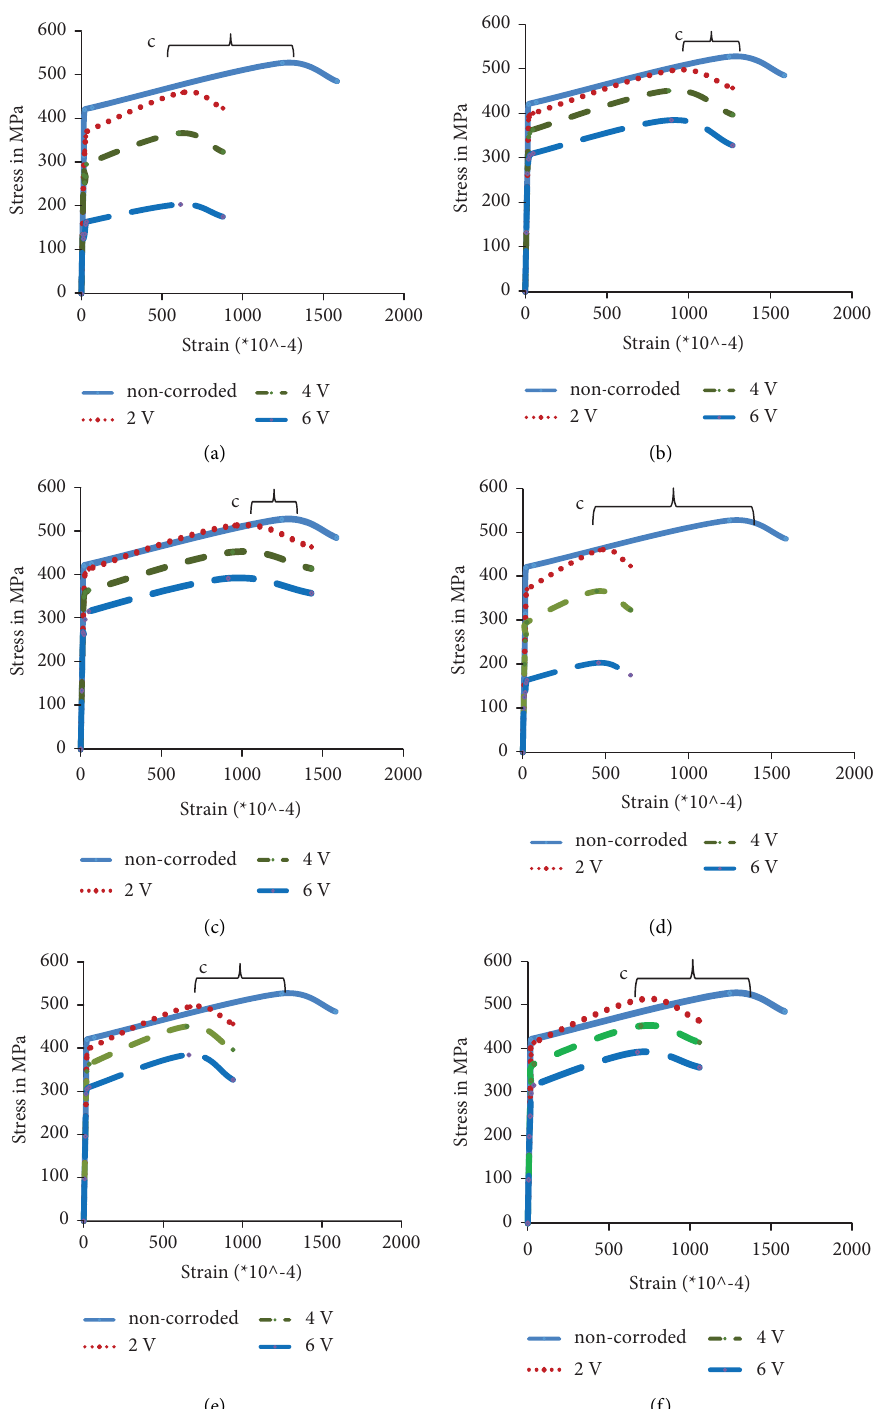
Figure 10: Comparison of stress-strain behaviour for (a, d) noncoated; (b, e) zinc coated; (c, f) nano PCB-coated rebars (“c” indicates the change in the ultimate strength). (a) Uncoated rebar (3.5% NaCl), (b) zinc coating (3.5% NaCl), (c) nano PCB-coating (3.5% NaCl), (d) uncoated rebar (10% NaCl), (e) zinc coating (10% NaCl), and (f) nano PCB (10%